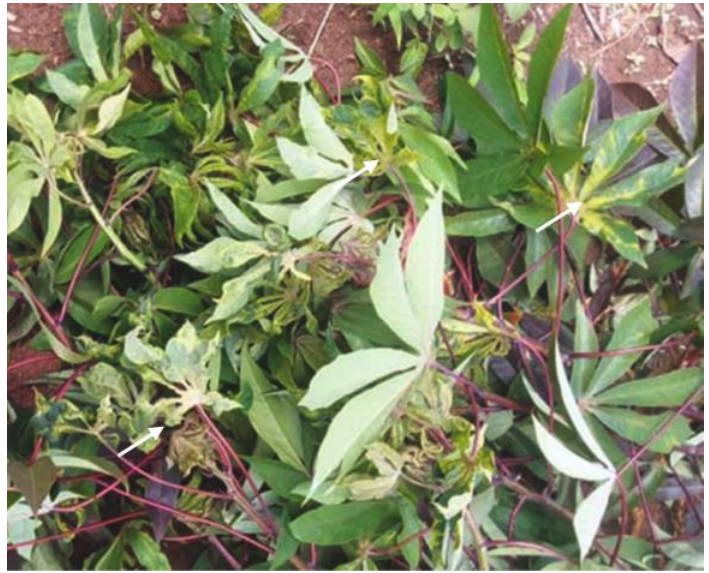
Figure 5. Virus resistance testing of cassava seedlings under field conditions. Typical mosaic and leaf curling symptoms (white arrows) on leaves of cassava seedling 17-5, family 17 confirm cassava mosaic virus infections introduced by viruliferous whiteflies and sensitivity of the South American cassava.